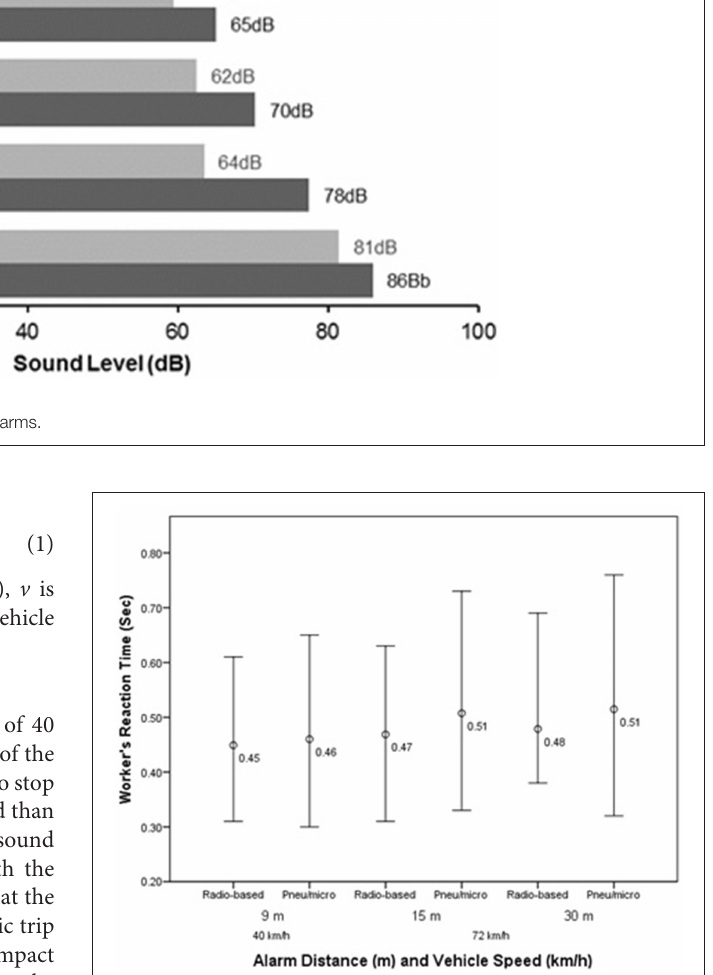
FIGURE 5 | Results of worker’s reaction